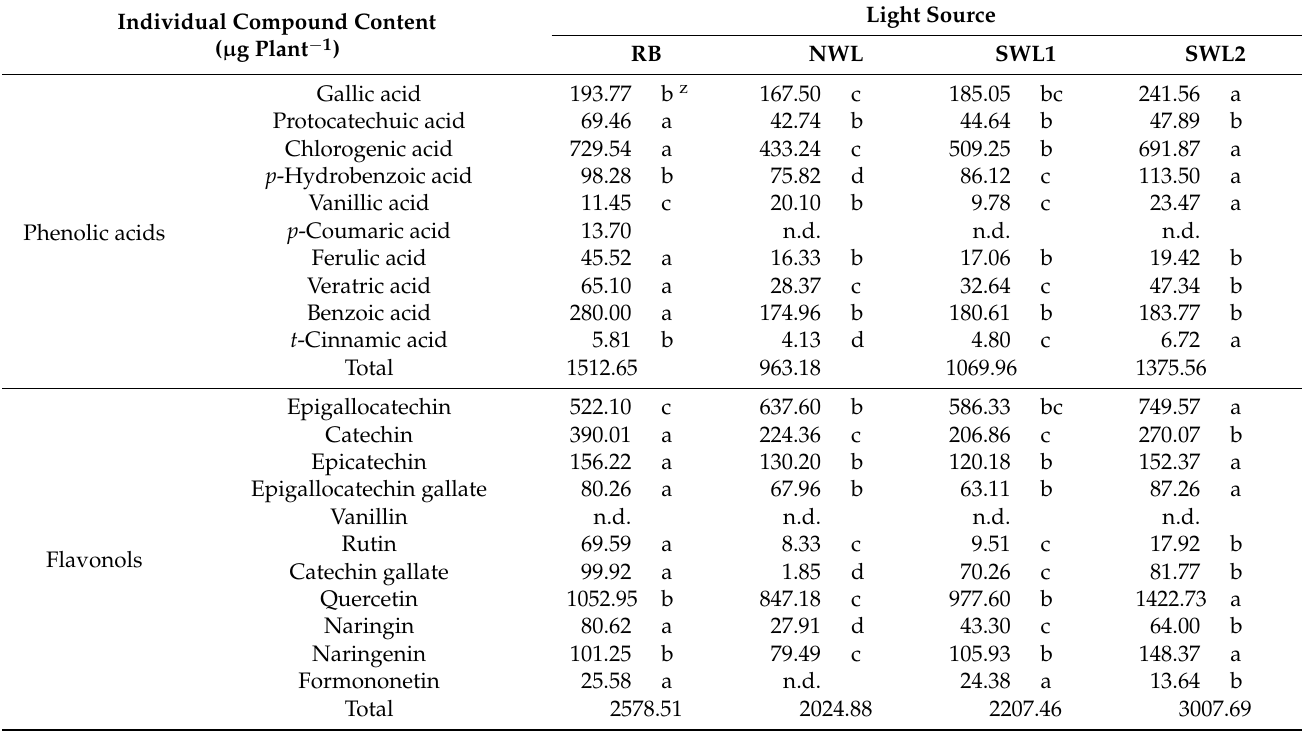
Table 5. Individual phenolic and flavonol contents of butterhead lettuce grown under various light sources with the same PPFD after 4 weeks of transplanting. Different letters indicate significant difference at p < 0.05 ( n = 4). Individual Compound